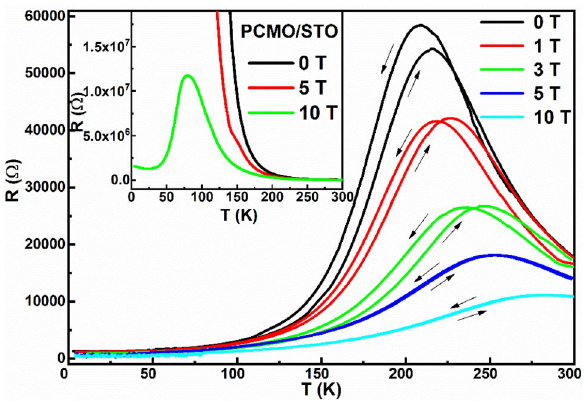
Figure 6. Temperature-dependent variation of resistance for various applied magnetic fields obtained for both cooling and warming cycles of PSMO/PCMO/STO heterostructure. Inset shows the temperature-dependent variation of resistance of PCMO/STO thin film.